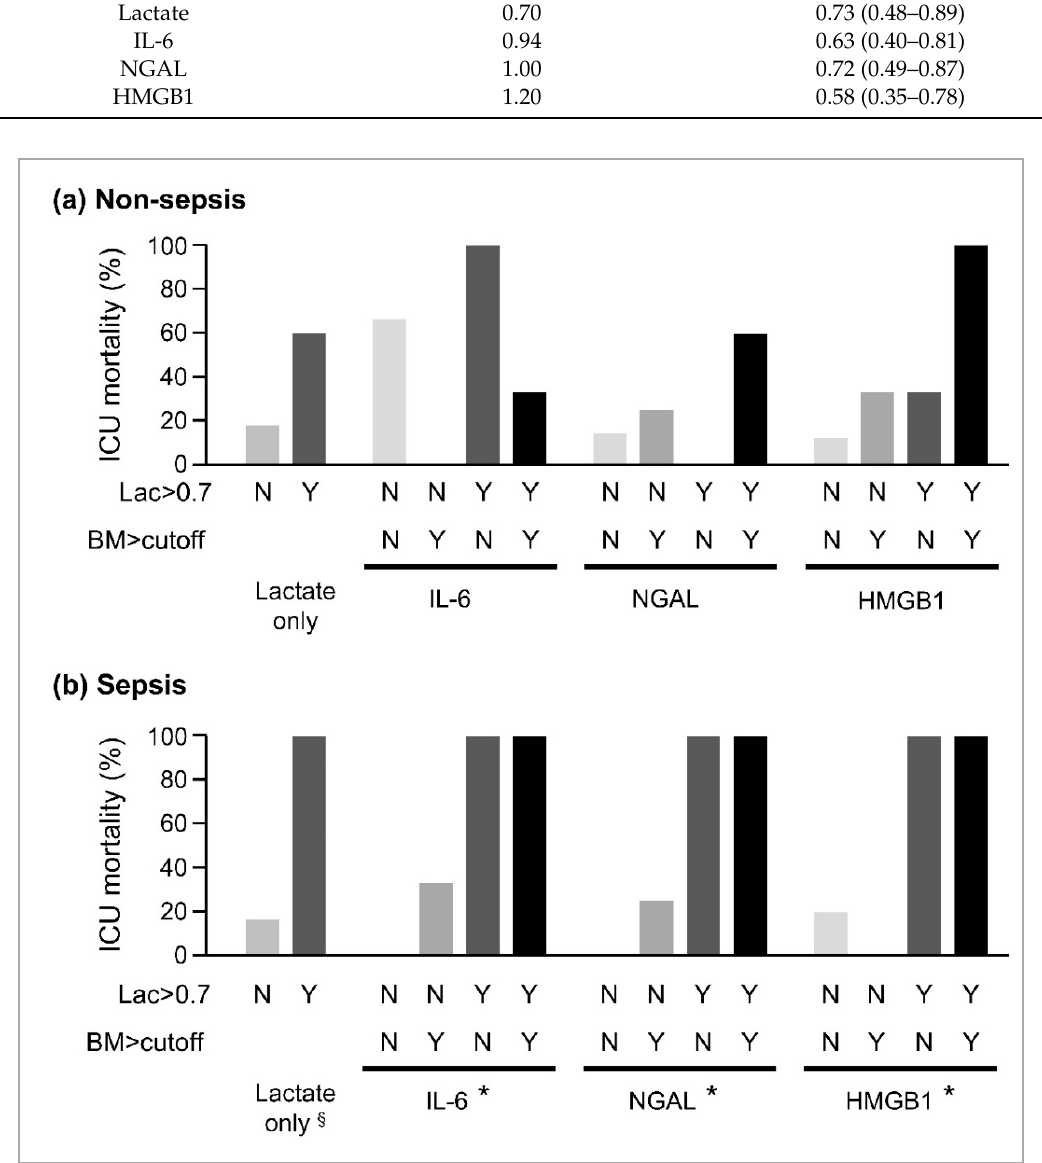
Figure 3. Combination with lactate and other biomarkers.